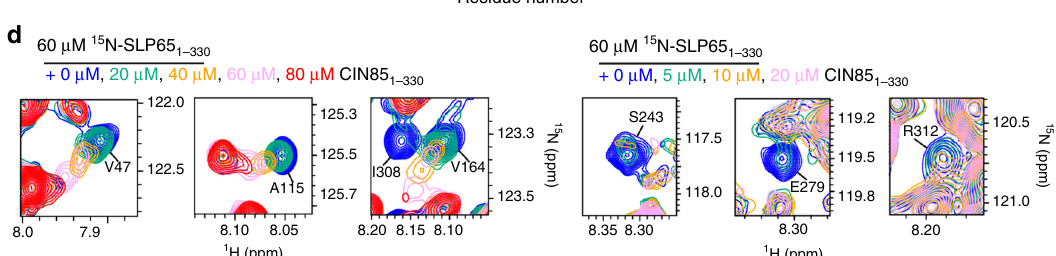
(LAT) 33 and Nephrin 34 at the relatively fl at plasma membrane. system compared to other phase-separating proteins studied so far.